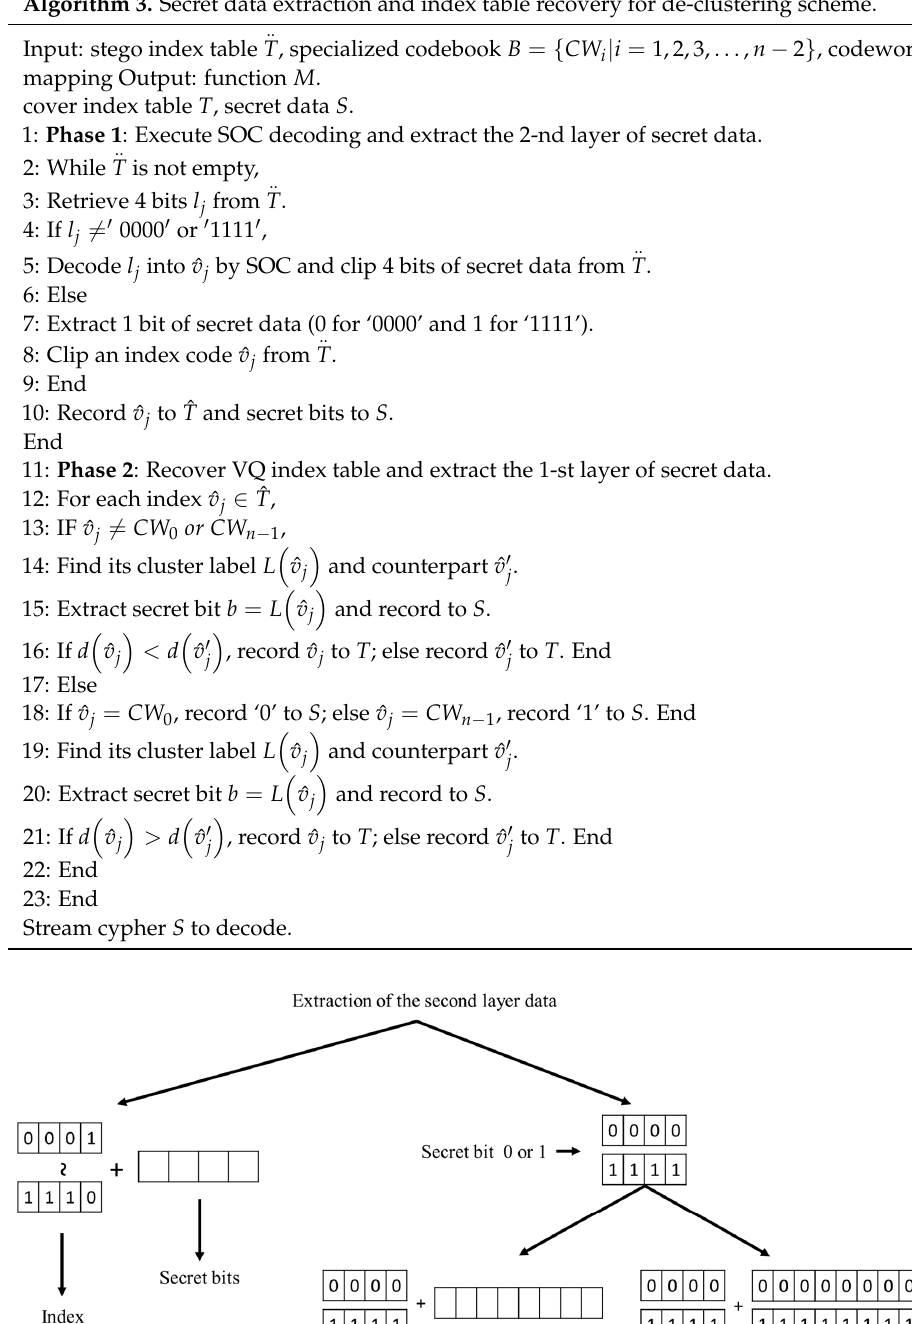
Algorithm 3. Secret data extraction and index table recovery for de-clustering